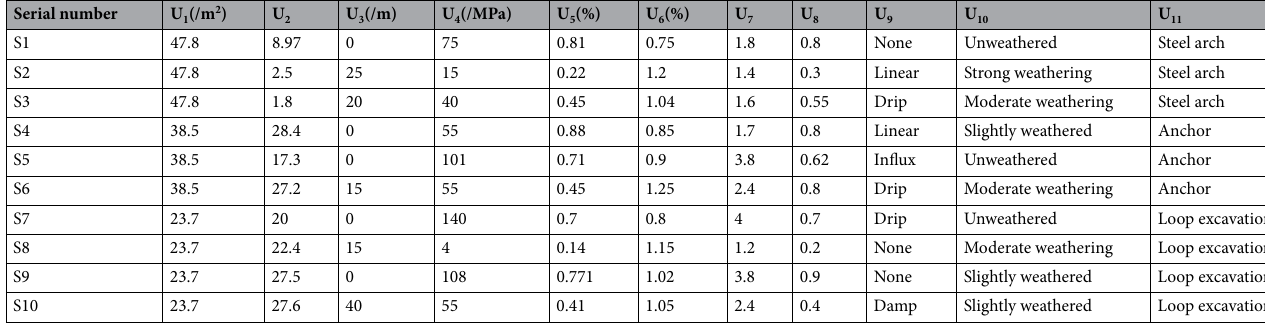
Table 1. Tunnel monitoring data.